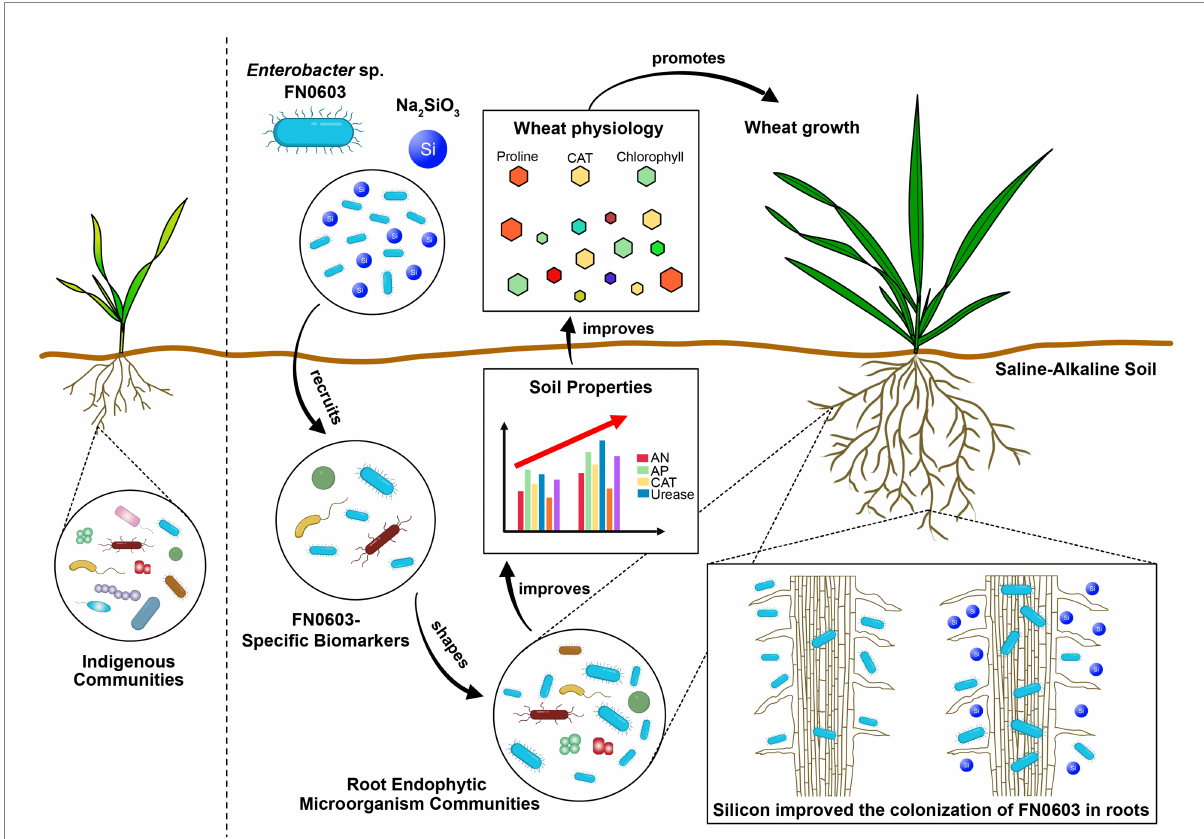
FIGURE 8 Mechanism of synergic wheat plant growth promotion by silicon and Enterobacter sp. FN0603 mitigate saline-alkaline